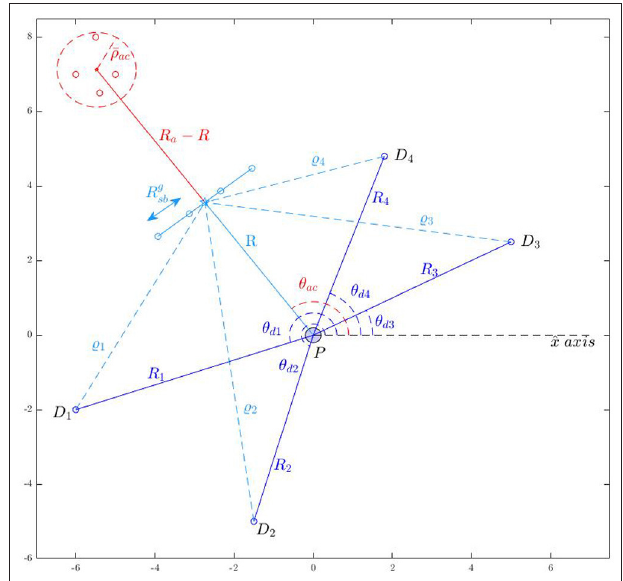
FIGURE 7 | Abstraction for estimate of dominance